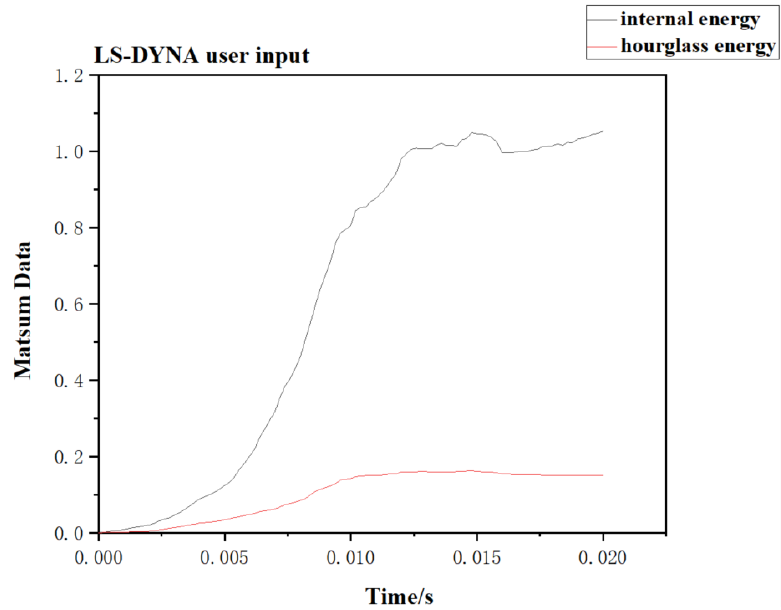
Figure 10. Energy change curve.